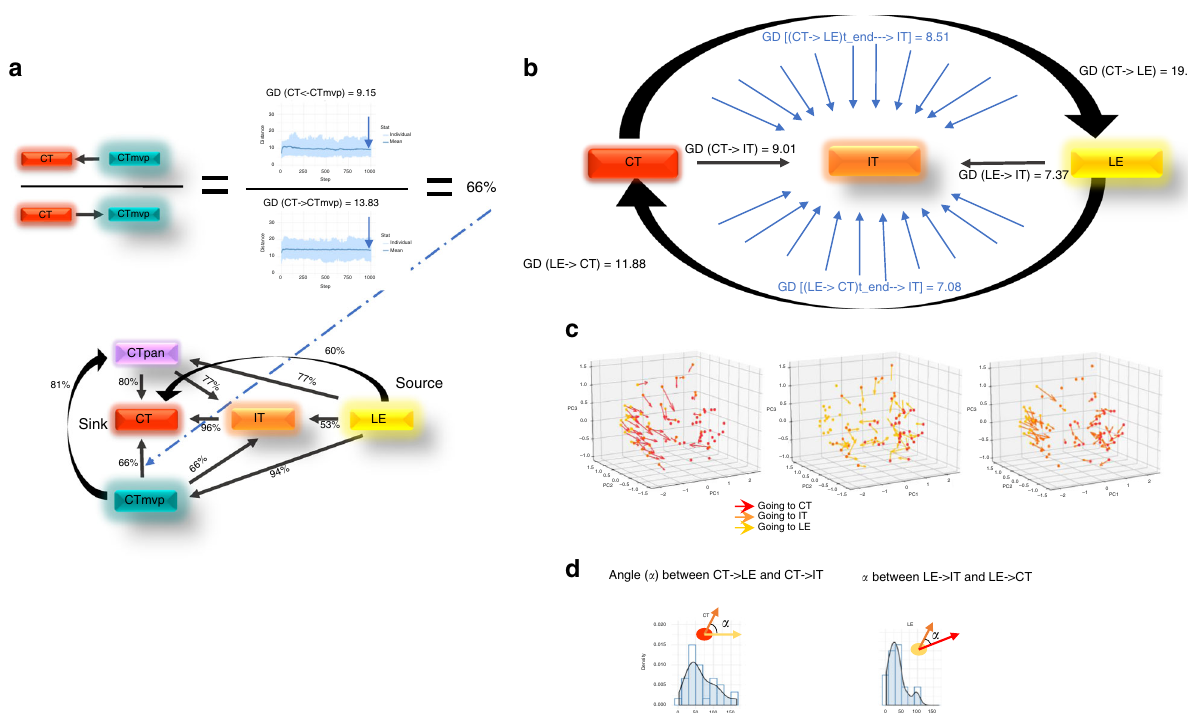
Fig. 4 Properties of the simulated phenotype dynamics. a The reverse process of transitioning between phenotypes was simulated for each edge of the location-based phenotype network from Fig. 3 (as seen by the reversal of the directions of the edges of the network in Fig. 4 compared to those of the network in Fig. 3). The ratio of global distance differences, and the ratio of number of converged pathways in square brackets, between the two directions are shown as weights. b – d The importance of spatially intermediate phenotype states. Focusing on the trajectory of CT → IT → LE, and the reverse trajectory, we examined three characteristics of the resulting intermediate phenotypes and the reversal process: b the ratios of the global distances between the two paths show that cells reverting their trajectory need smaller changes in phenotype to get back from LE to CT, compared to reaching LE from CT using the original path: they are closer to the target phenotype when reverting (11.88 distance) compared to the original end point (19.92); c vector fi elds of the simulated phenotype dynamics were plotted using PCA; the arrow origins are the starting phenotypes ( t = 0) and the end points are the simulated phenotypes ( t = 1000). The color of the dots corresponds to the starting phenotype location, whereas the colors of the arrows depict the target phenotype; for example, red arrows that start from a yellow dot are simulation results of a case where the initial condition is LE, and the target phenotype is CT; D) the angles between the original paths of CT → LE and CT → IT, and angles between the reversal paths LE → CT and LE → IT are narrow, which indicates a constrained sphenotype exploration